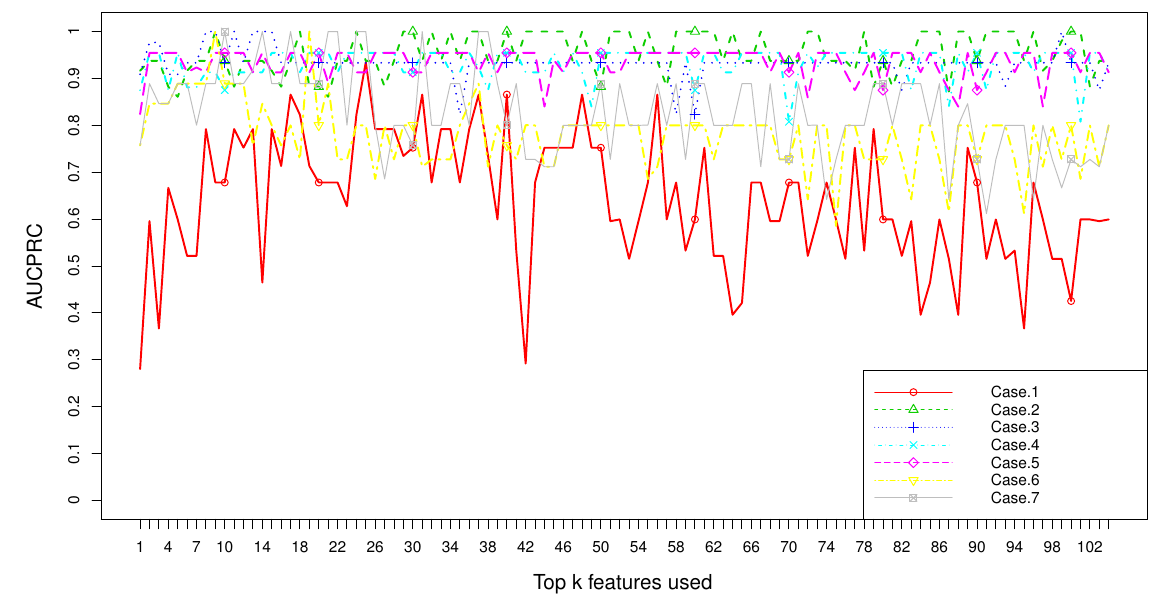
Figure 10. AUCPRC when top k features are used with the dataset “ATR” on seven cases. Re-balanced datasets were artificially generated and utilized in cases 2–7 from Tables 1–4. Of all the 96 scenarios with re-balance, the aggregation rank method reached the maximal measures in 83 scenarios compared to the other eight filtering methods. It means that aggregation rank outperformed single filtering rank with the proportion of